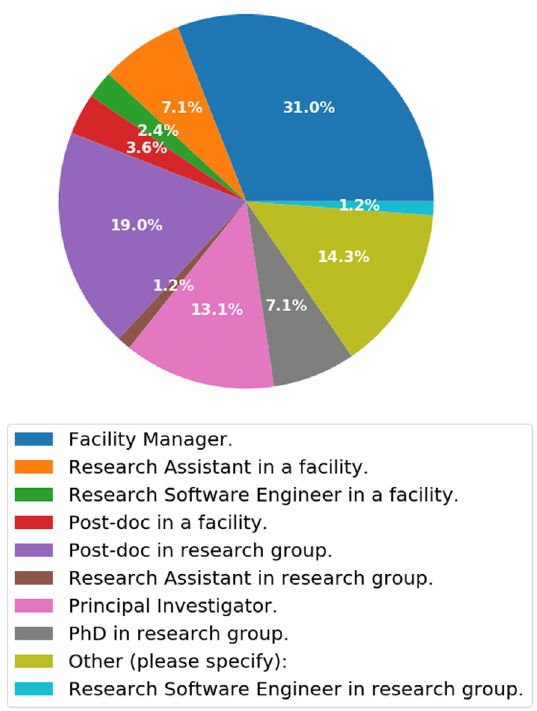
Figure 5. Pie chart representing answers from Q1.5. Participants were able to select only one answer.